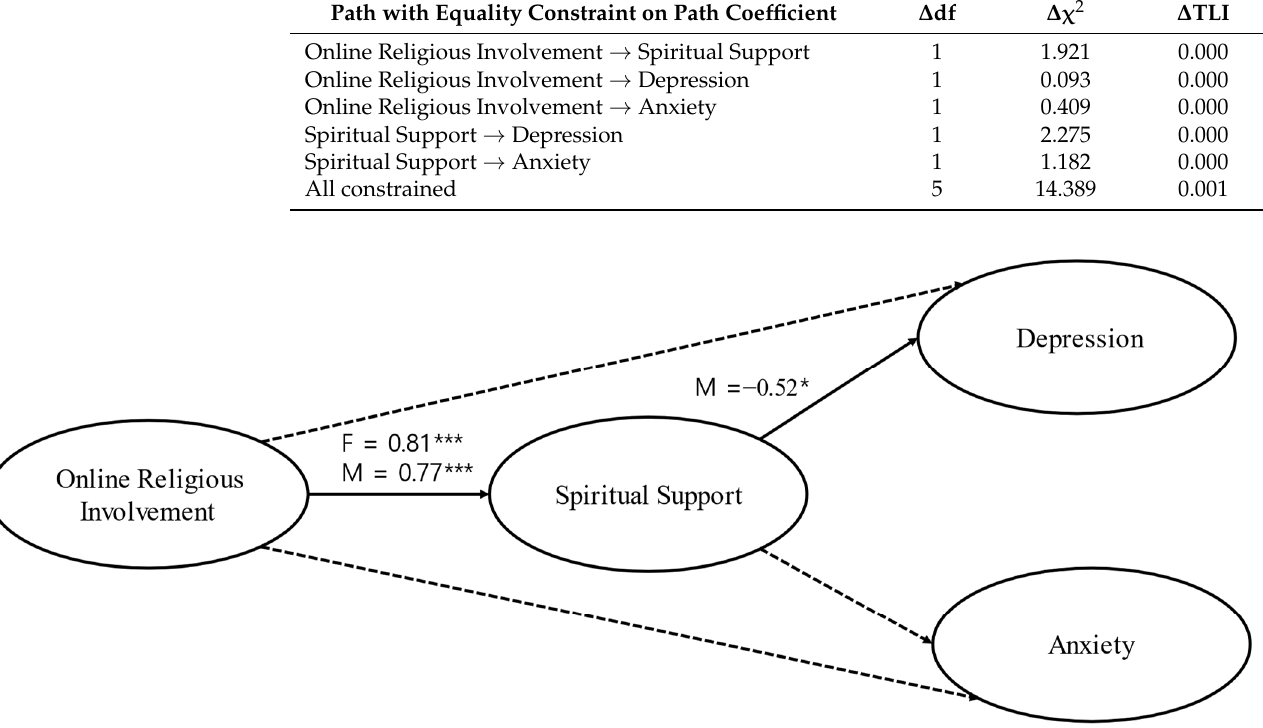
Figure 1. Final model estimation with standardized coefficients. Note : F and M mean female and male, respectively. Significant (* p < 0.05, *** p < 0.001) path coefficients are shown with bold lines; non-significant path coefficients are shown with dotted lines.